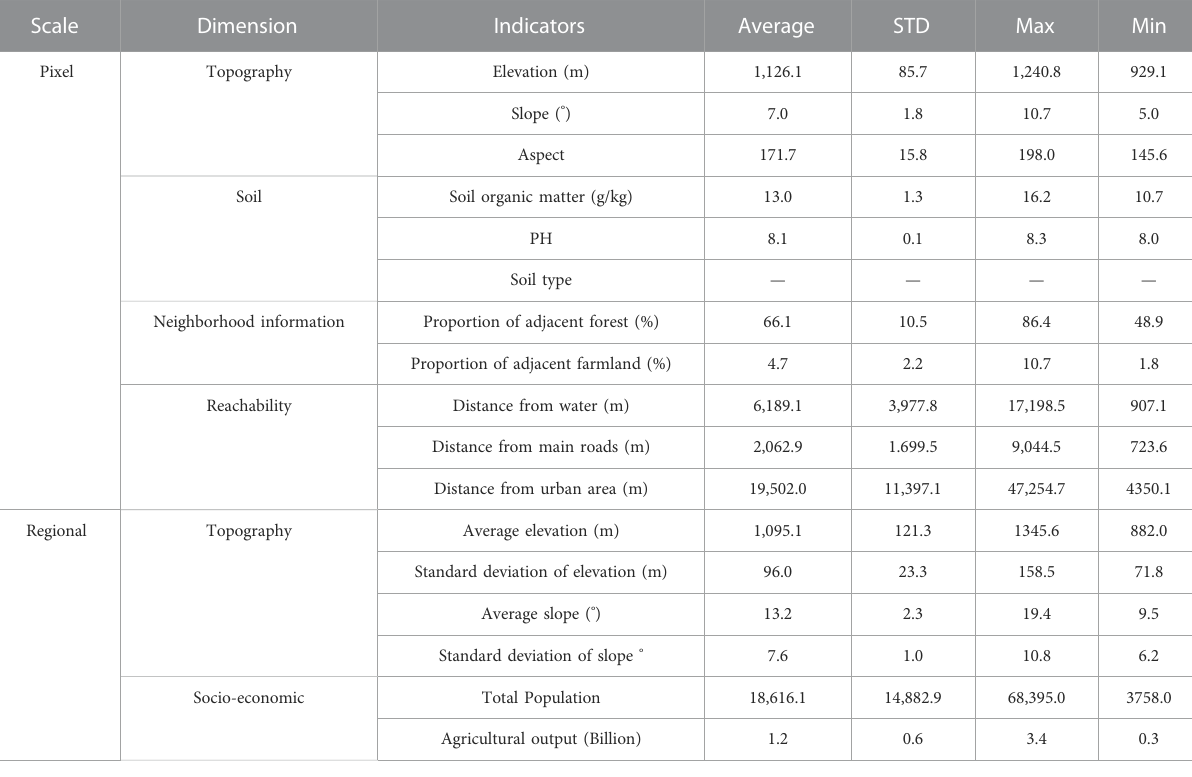
TABLE 3 Descriptive statistics of the selected Evaluation indicator of orchard expansion.